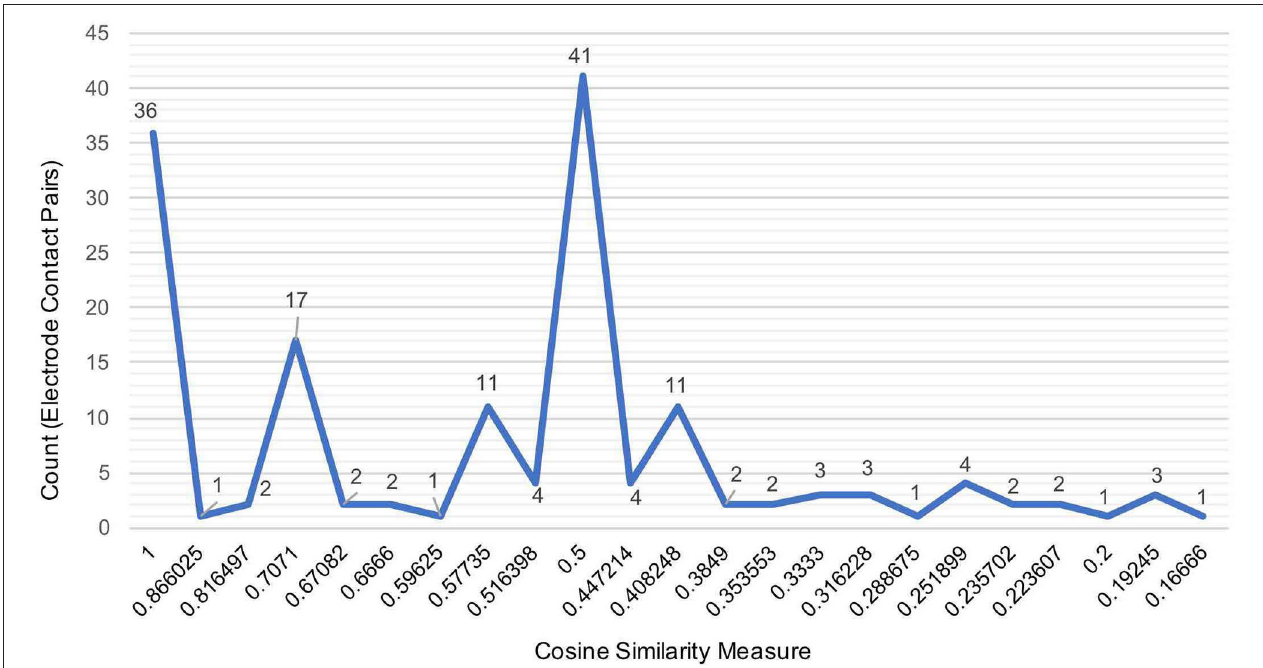
FIGURE 3 | The distribution of the aggregated count of electrode pairs corresponding to cosine similarity values that are used to compute clustering of brain regions in 27 events across 8 seizures to generate dendrograms shown in the previous figure.